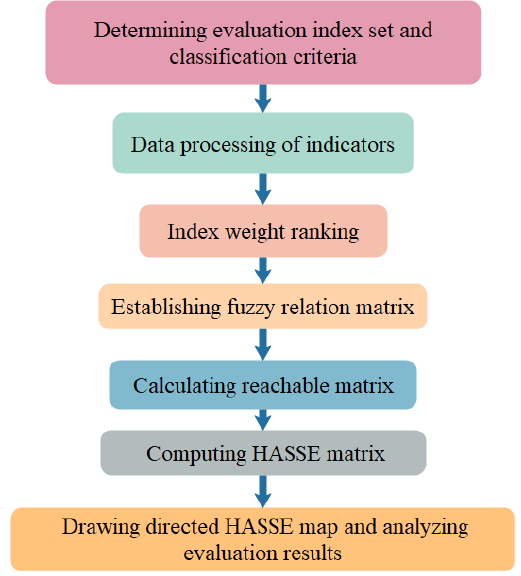
Figure 1. The flowchart of the entropy weight ‐ Hasse diagram technology (HDT).